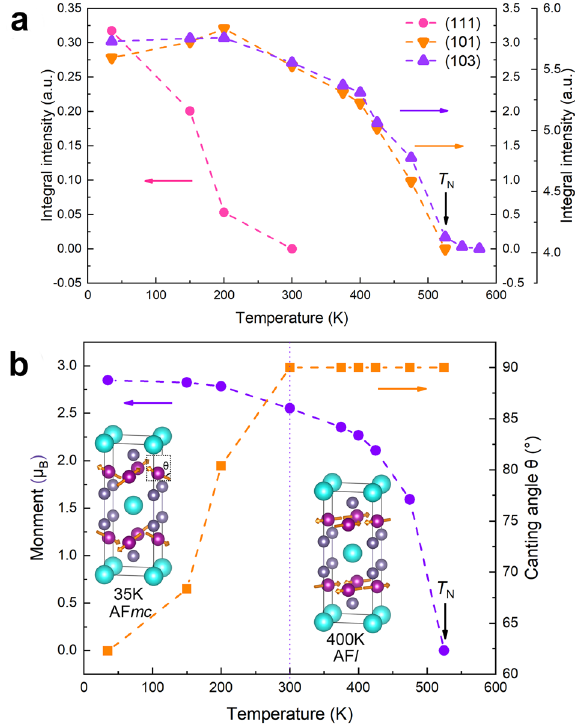
Fig. 2 Evolution of magnetic structure. Temperature dependence of a the integrated intensity of (101), (103), and (111) re fl ections, and b the magnetic moment and the canting angle, θ , of Mn atoms. The insets show the two antiferromagnetic structures of AF mc and AF l